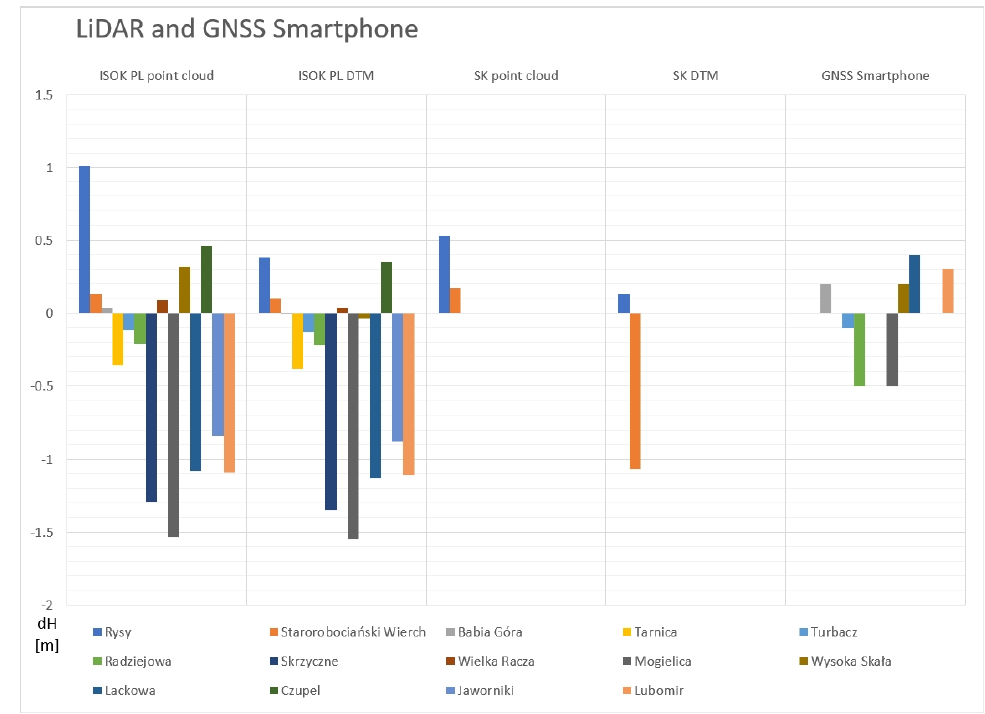
Figure A1. Height difference with GNSS surveying for point clouds, DTM models, and smartphone GNSS survey. Source: authors.